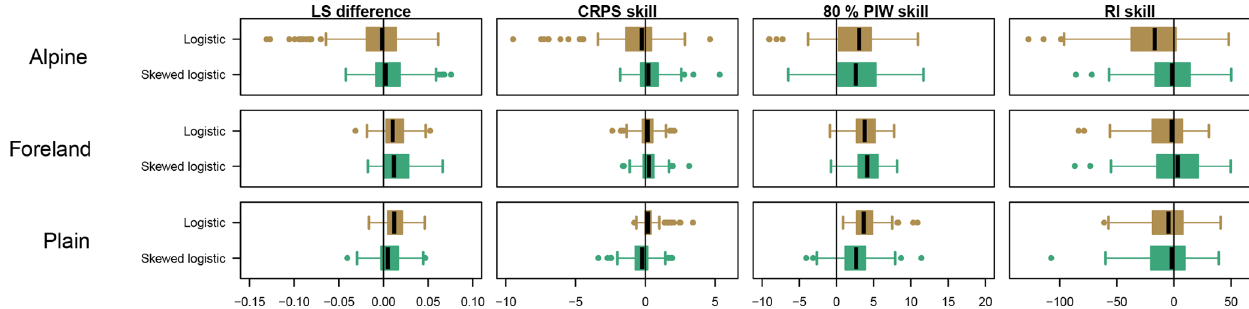
Figure 7. As in Fig. 6, but showing the improvement against the classical Gaussian model. Note that improvements are reported by positive values. Differences are shown for LS, whereas skill scores (in %) are shown for CRPS, the 80% PIW, and the RI. Table 2. Median of (left to right) the logarithmic score (LS), the continuous ranked probability score (CRPS), the reliability index (RI), and three prediction intervals (PIs) reporting the prediction interval width (PIW) and the prediction interval coverage (PIC) for Alpine, foreland, and plain sites (top to bottom), evaluated for each model type (Gaussian, logistic, and skewed logistic). Model LS CRPS RI PI